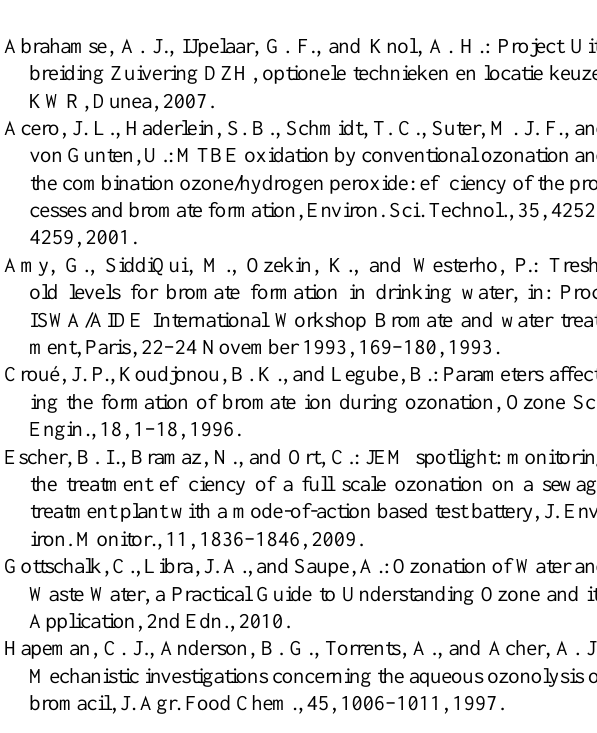
ciently degraded organic micropollutants with aromatic rings and/or unsaturated C-C bonds in their molecular